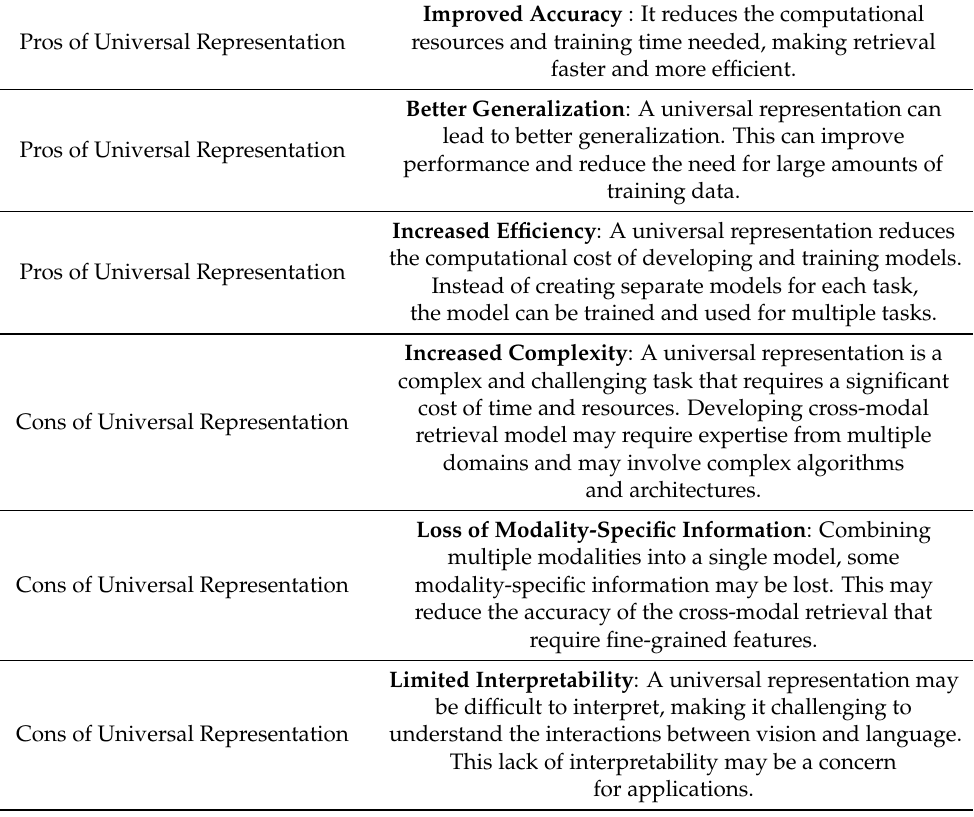
Table 3. Pros and cons of V-L